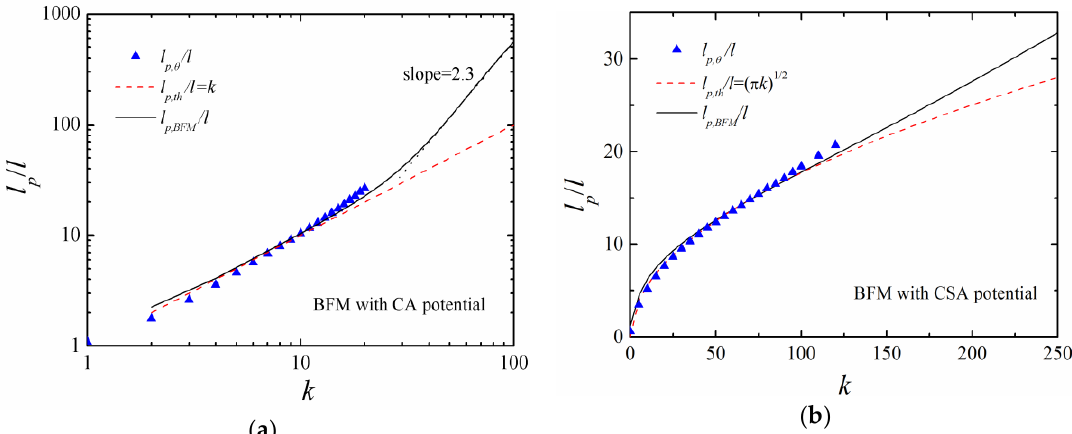
Figure 9. The theoretical persistence lengths in BFM and continuous simulations and simulation result l p,θ with ( a ) CA and ( b ) CSA potentials, respectively. l p, θ with ( a ) CA and ( b ) CSA potentials, respectively.